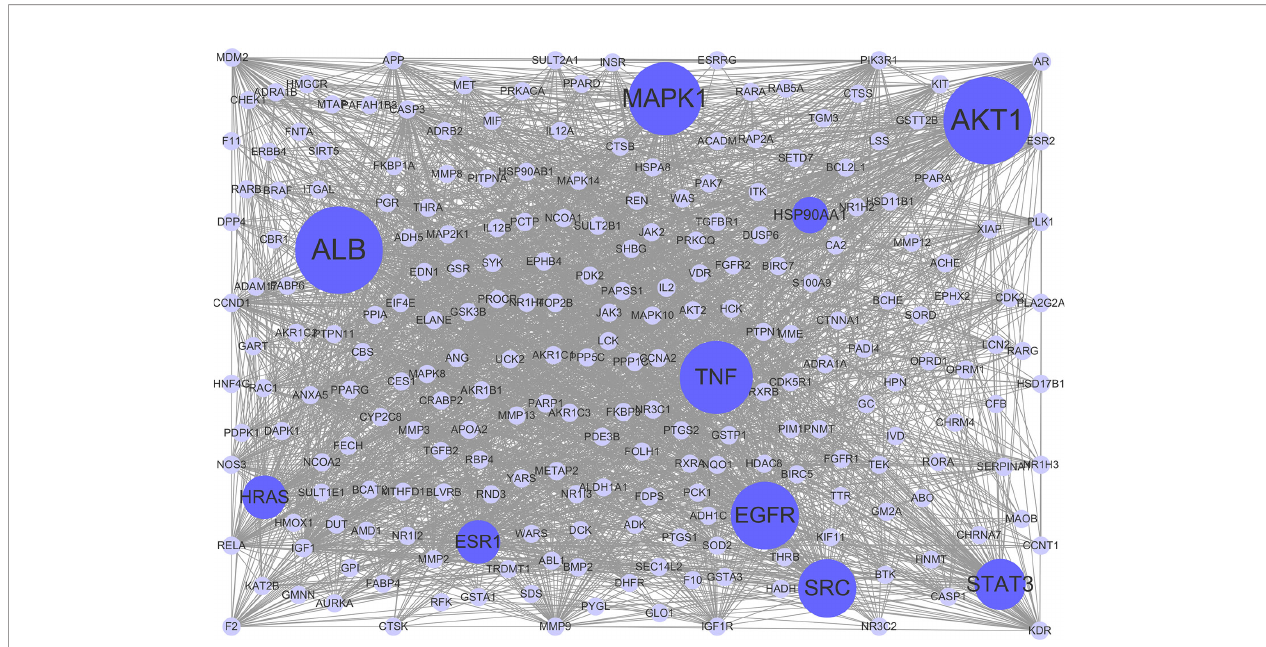
FIGURE 3 | Protein-protein interaction (PPI) network. The nodes get larger with increasing degree. Edges: PPIs between targets of cryptotanshinone (CPT) and their interaction partners; purple circle nodes: common targets of CPT and human hepatocellular carcinoma (HCC); dark purple circle nodes: hub targets of CPT and HCC (Degree ≥